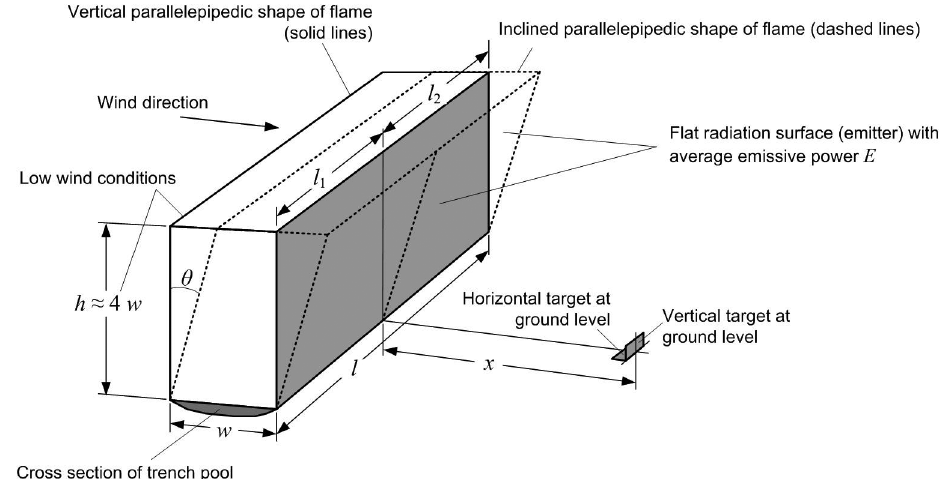
Figure 6. The solid flame model for a trench fire with papallelepipedic